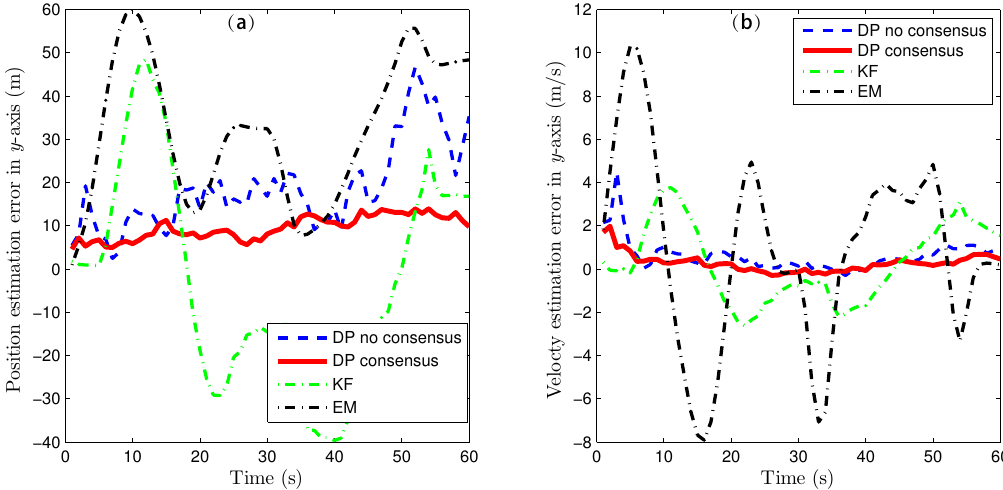
Figure 8. State estimation errors in the y direction using the KF, DP consensus, DP no consensus and EM methods for sensor 4. ( a ) position estimation; ( b ) velocty